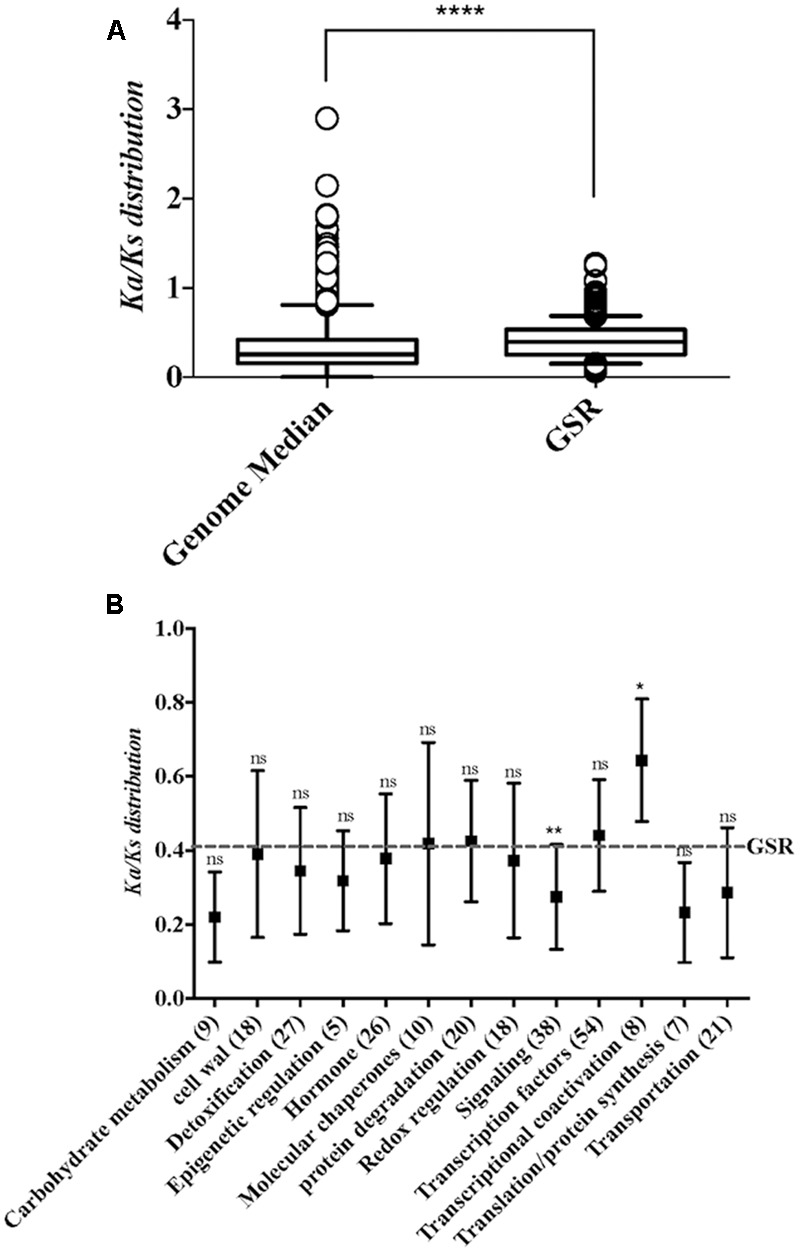
The distributions of Ka/Ks ratio in whole genome and functional categories within GSR genes. (A) Boxplot depicts the Ka/Ks ratio of the genome median and GSR genes. Because the data failed normality test, statistical significance was calculated using Mann–Whitney test. ∗∗∗∗p < 0.0001. (B) Boxplot represents the Ka/Ks ratio of different functional categories in GSR genes. The Ka/Ks mean value of GSR genes is represented by dotted line. The x-axis shows the functional categories and gene numbers in each category. Significance was calculated by comparing each category to total GSR genes. Because the data failed normality test, statistical significance between two groups was calculated using Kruskal–Wallis test followed by Dunn’s test for post hoc analysis. ∗p < 0.05, ∗∗p < 0.01; ns, not significant.